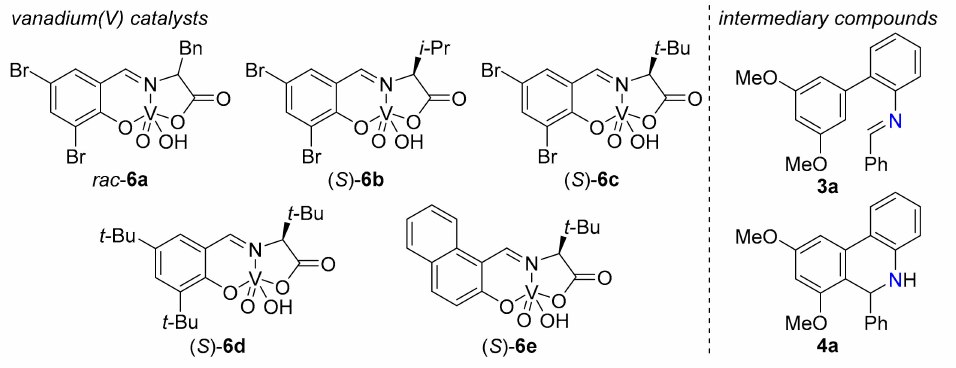
Figure 2. Structures of vanadium(V) complexes and observed